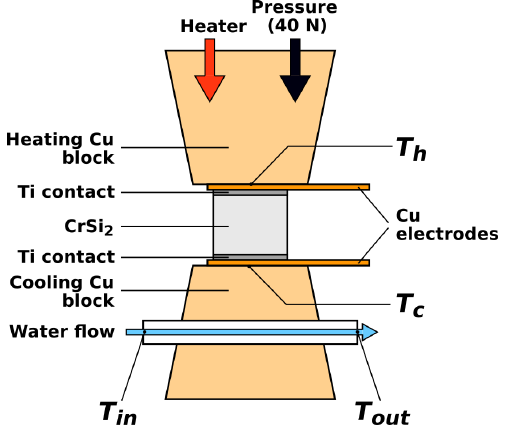
Figure 1. Scheme of the thermoelectric leg characterization set-up used in the present work (MiniPEM,